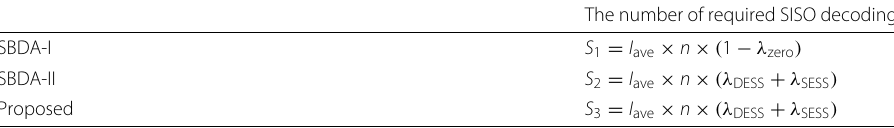
Table 1 The usage number of SISO decoding in each syndrome-based decoding algorithm